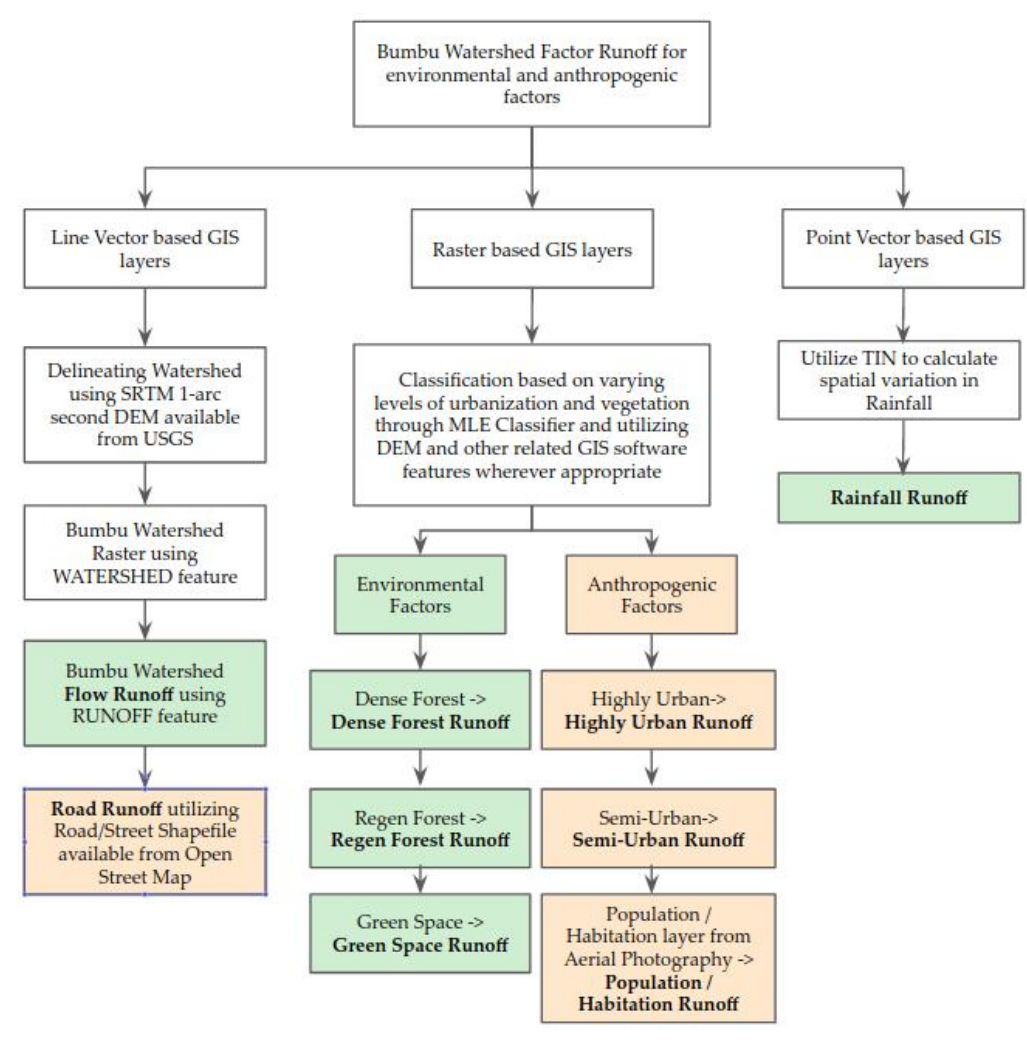
Figure 3. Flow chart depicting different anthropogenic and environmental factors influencing runoff and their characterization based on point-, line- and raster-based GIS layers.